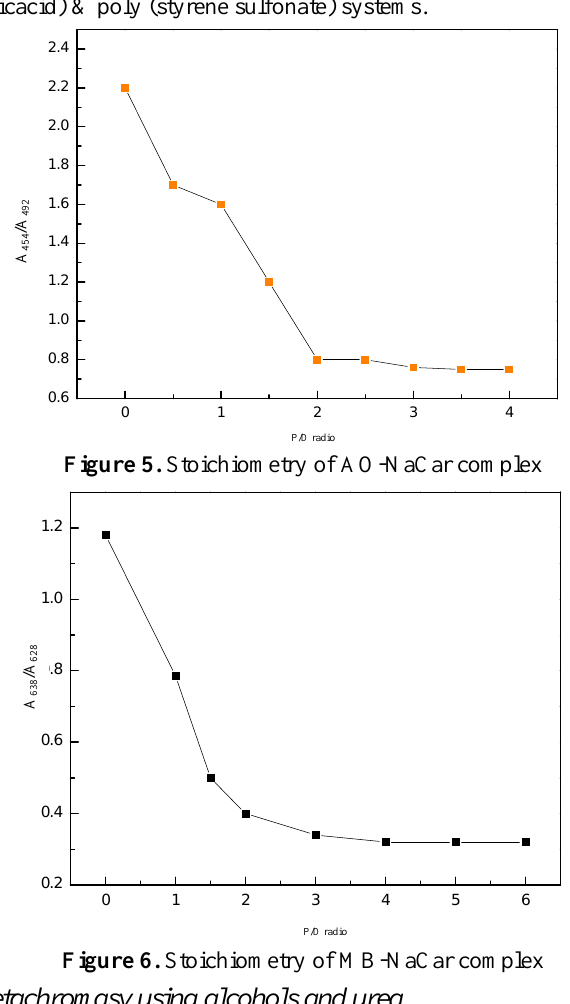
Figure 6. Stoichiometry of MB-NaCar